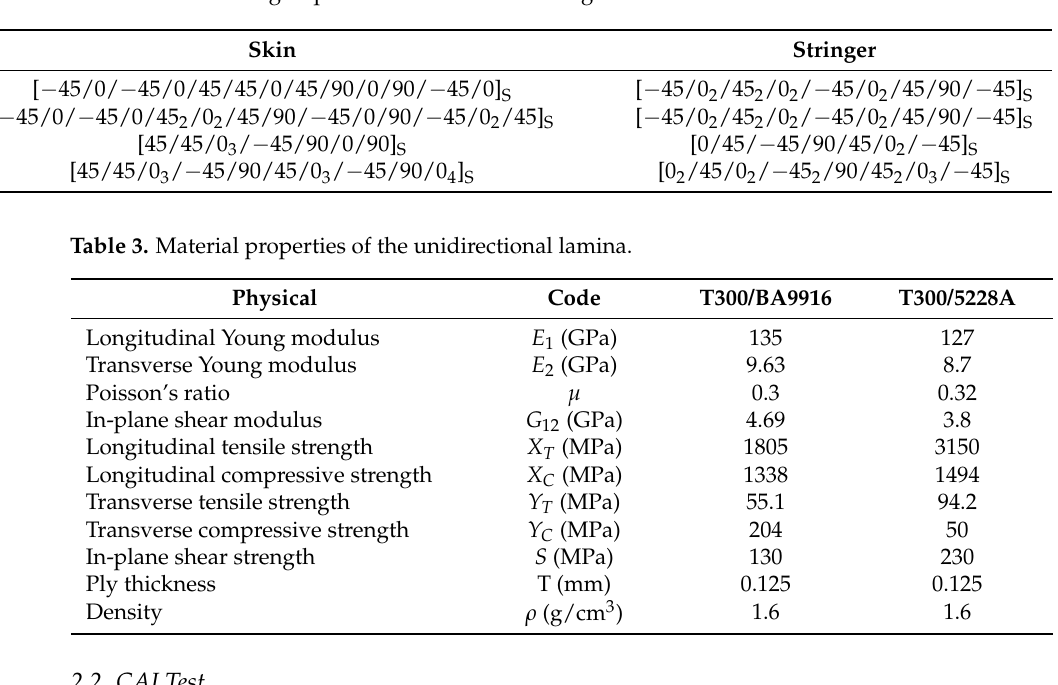
Table 2. The stacking sequence of the skin and stringer.